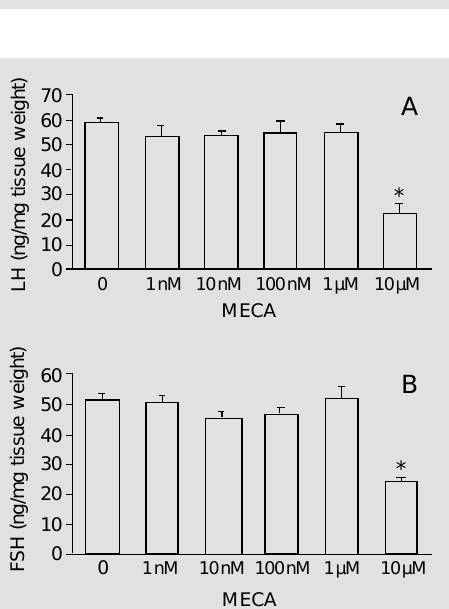
Figure 3 - Effects of administra- tion of different MECA concen- trations on basal LH (A) and FSH (B) secretion. The preparation conditions are the same as de- scribed in the legend to Figure 1. Data are reported as means ± SEM (N = 5). *P<0.05 compared to control (0) (Newman-Keuls